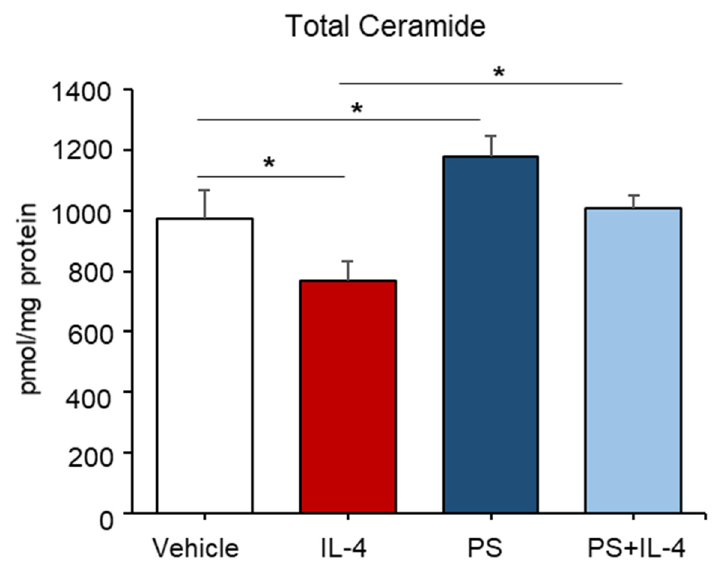
Figure 2. An IL-4-induced decrease in ceramide content was stimulated in cells following N-palmitoyl serinol (PS) treatment. HaCaT KC were pretreated with IL-4 (50 ng/mL) for 20 h, followed by incubation with exogenous PS (25 µ M) for 4 h. Total ceramide content was assessed by the LC- MS/MS system. Statistical significance was calculated using the unpaired Student’s t -test, and significance was defined as * p < 0.01 vs. vehicle control (or untreated control).